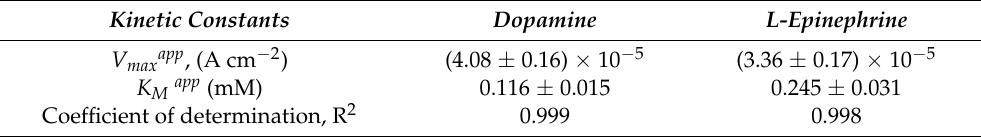
Figure 8. Dependence of the current density on catecholamine concentrations (electrochemical Michaelis–Menten plot); working electrodes: laccase immobilized on cystamine monolayer in the presence of dopamine ( A ) and L-epinephrine ( B ); citrate buffer, pH = 4.0; working potential − 0.1 V (vs. Ag|AgCl, sat. KCl); 20 ± 1 °C. Table 1. Kinetic constants of the immobilized laccase calculated from non-linear least-square regres- sion by fitting the data to a hyperbolic function based on chronoamperometric plots recorded at an operating potential of − 0.1 V.